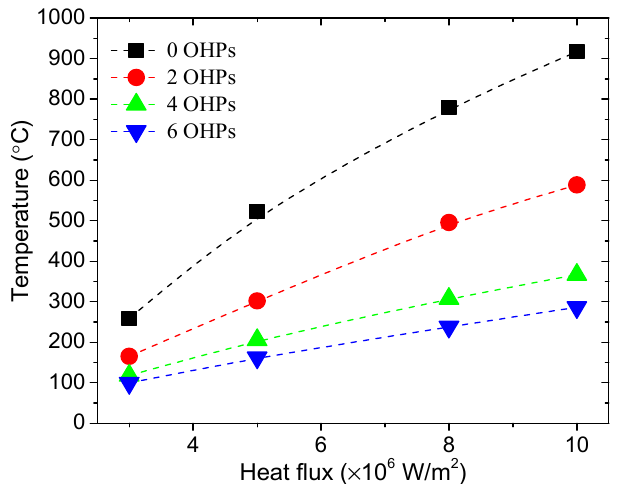
Figure 6. The highest temperature in the grinding zone under different grinding heat flux values.